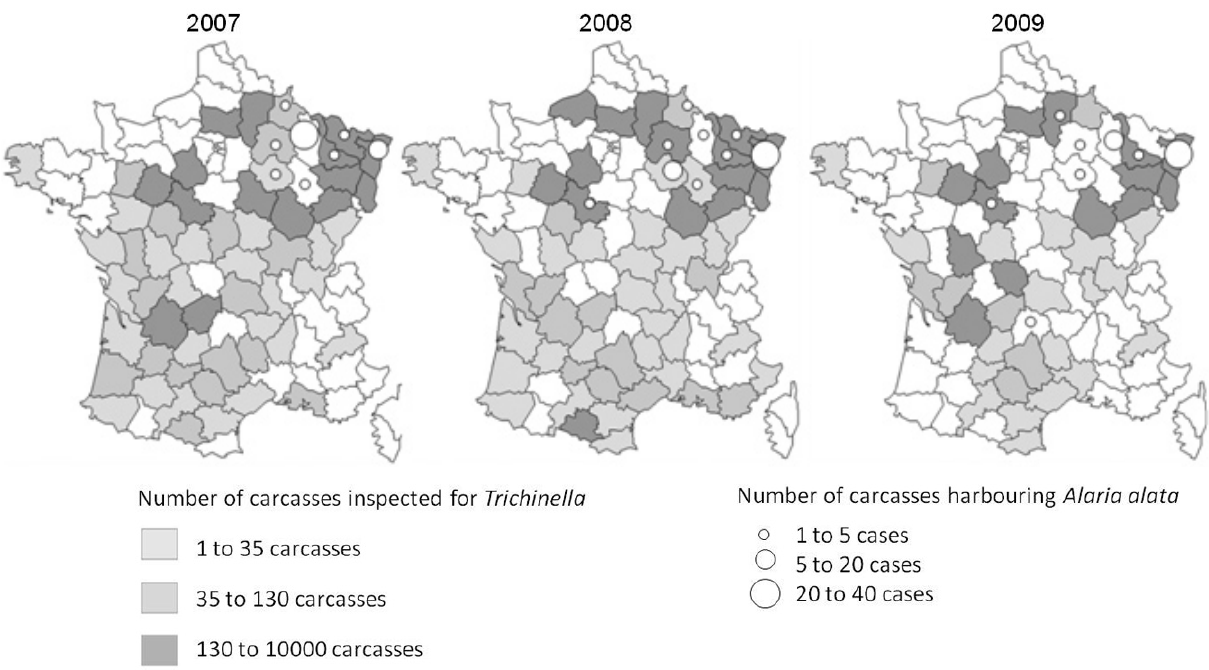
Fig 1. – Geographical distribution of mesocercariosis cases and intensity of Trichinella inspection on wild boars’